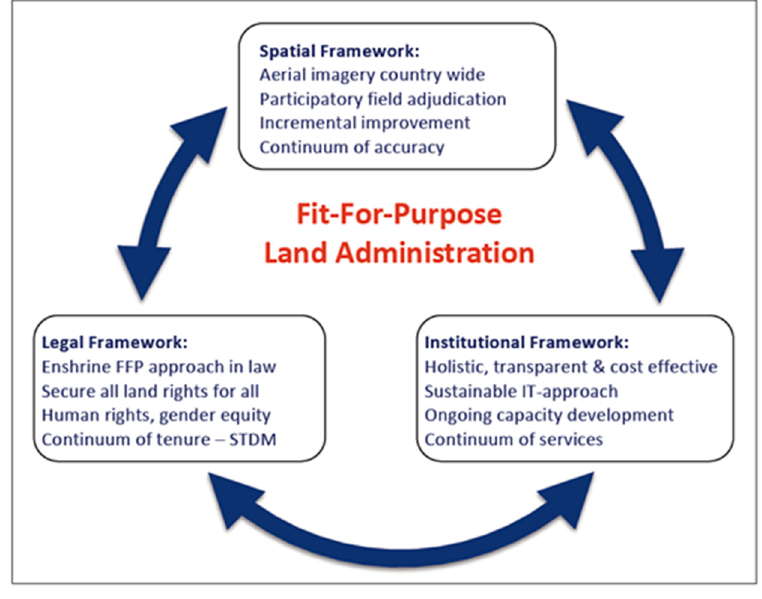
Figure 1. The FFPLA concept [12] (p.